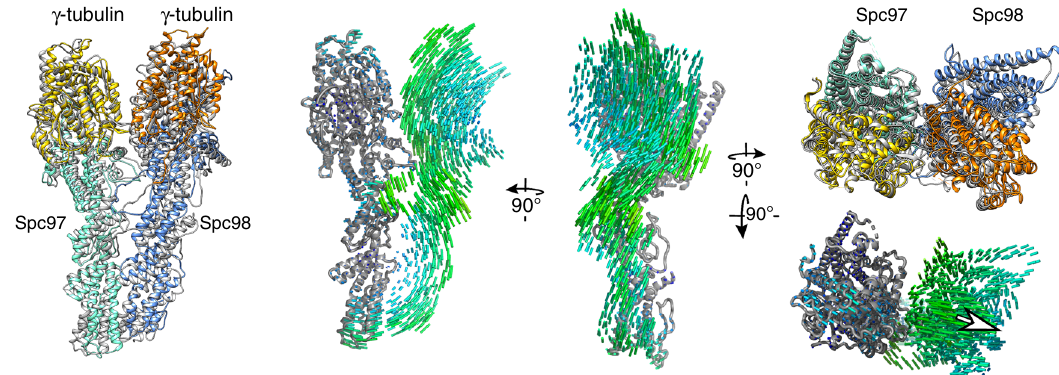
Fig. 4 The C. albicans γ -TuSC requires conformational rearrangements during or after oligomerization. Atomic models for the C. albicans ( a , gray) and vertebrate ( b , gray) γ -TuSC units were superposed to the S. cerevisiae γ -TuSC in the closed conformation (colored) according to the fi rst spoke (Spc97/ GCP2 plus γ -tubulin). The displacement of domains was visualized by trajectories linking the backbone atoms in the two superposed models. For orientation, atomic models for the fi rst spoke are superposed to trajectories. Trajectories are color-coded from low (blue) to high (red) motion. In the ‘ top view ’ , arrows representing the average direction and magnitude of γ -tubulin displacement are superposed to the